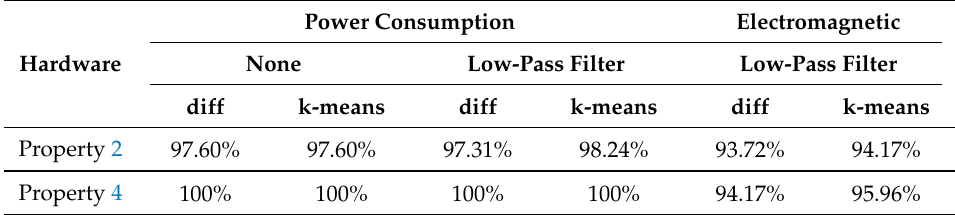
Table 2. Experimental results: software implementations.